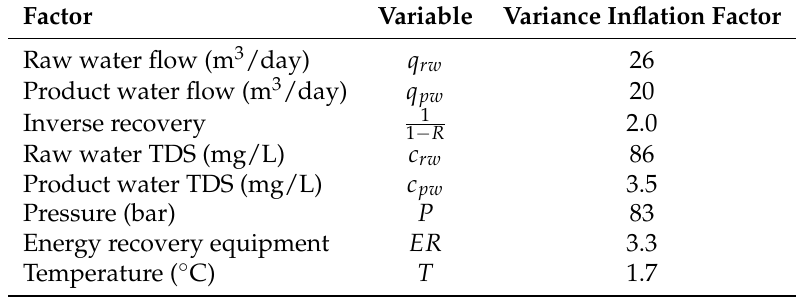
Table A1. Variance inflation factors (VIF) for variables considered in the small-scale multiple linear regression model show some strong multicollinearity where VIF > 10. Values have been rounded to two significant figures.